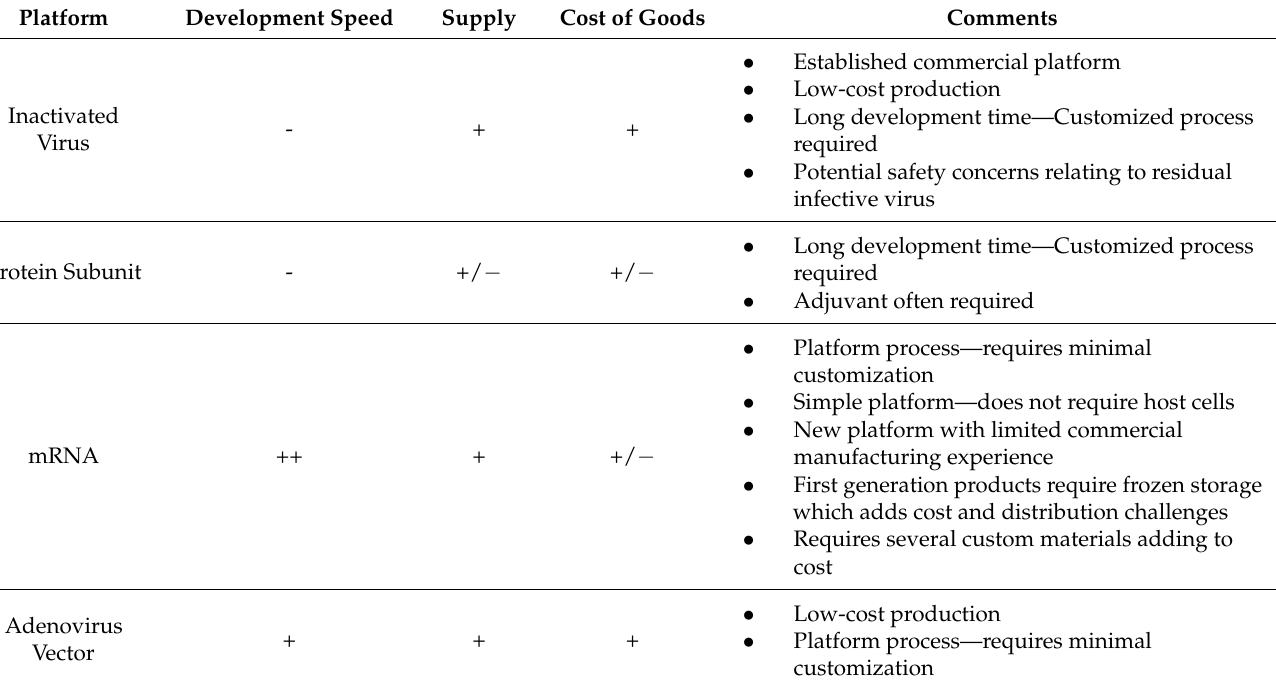
Table 2. COVID-19 vaccine